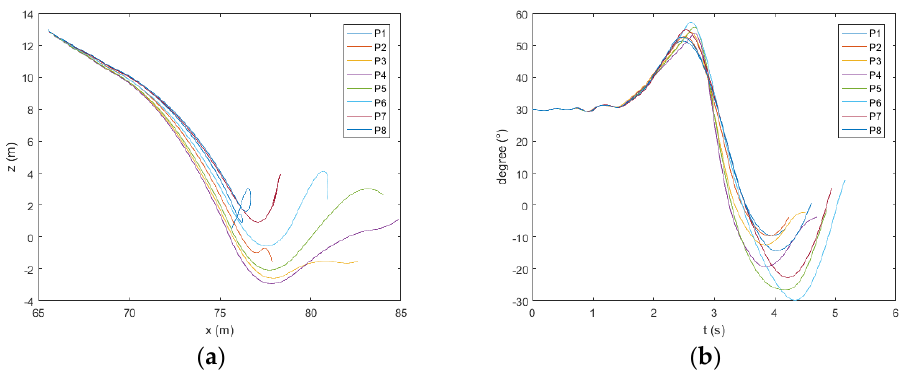
Figure 23. Trajectory ( a ) and pitch ( b ) of the lifeboat freefall when the wave height is 5 m.